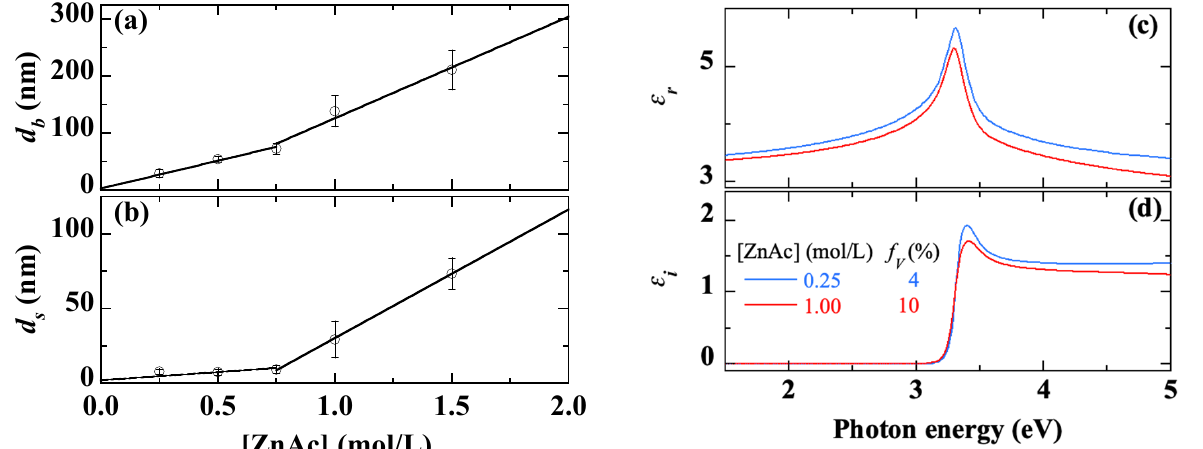
Figure 6. Thickness of the bulk layer ( a ) and the surface roughness ( b ), real ( c ) and imaginary ( d ) parts of the dielectric function extracted from SE measurements on sol-gel spin-coated ZnO samples obtained with various ZnAc contents. The straight lines in Figures ( a , b ) are provided as guides for the eye.